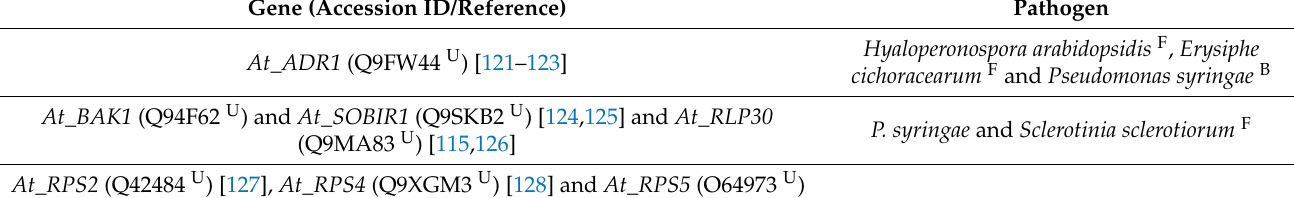
Table 2. The 49 cloned R genes from Arabidopsis thaliana (At), Brassica juncea (Bju), Brassica napus (Bna) and Brassica rapa (Bra) used for homology